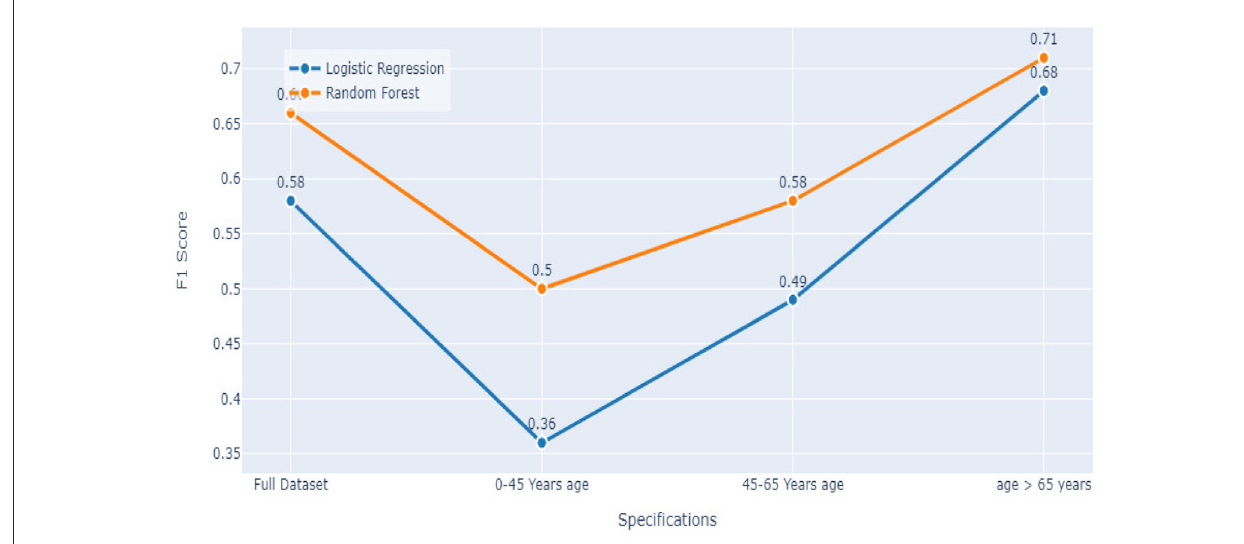
FIGURE9 Models F1 score comparison.